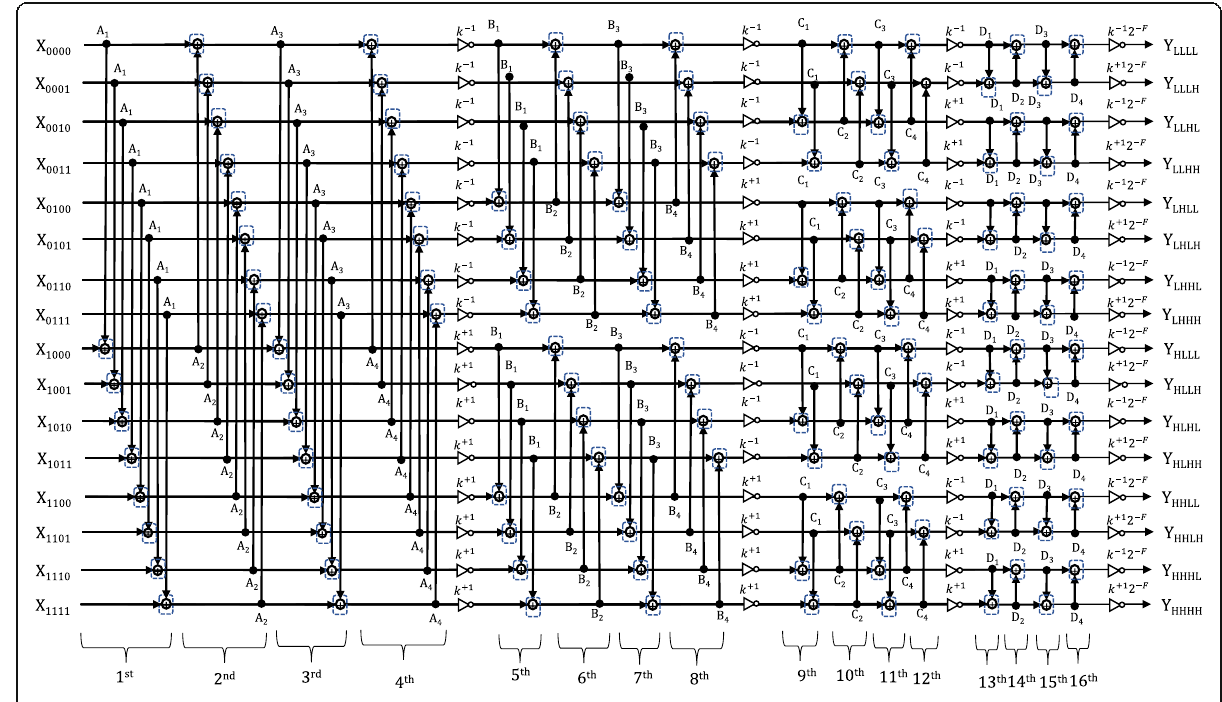
Fig. 4 Separable 4D structure for 9/7-type of transform (existing I)